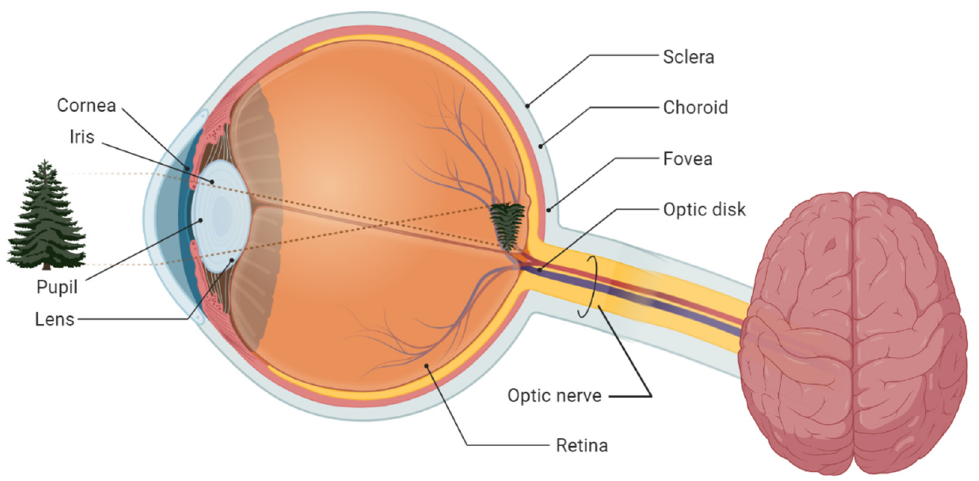
Figure 1. Scheme of the human visual system.